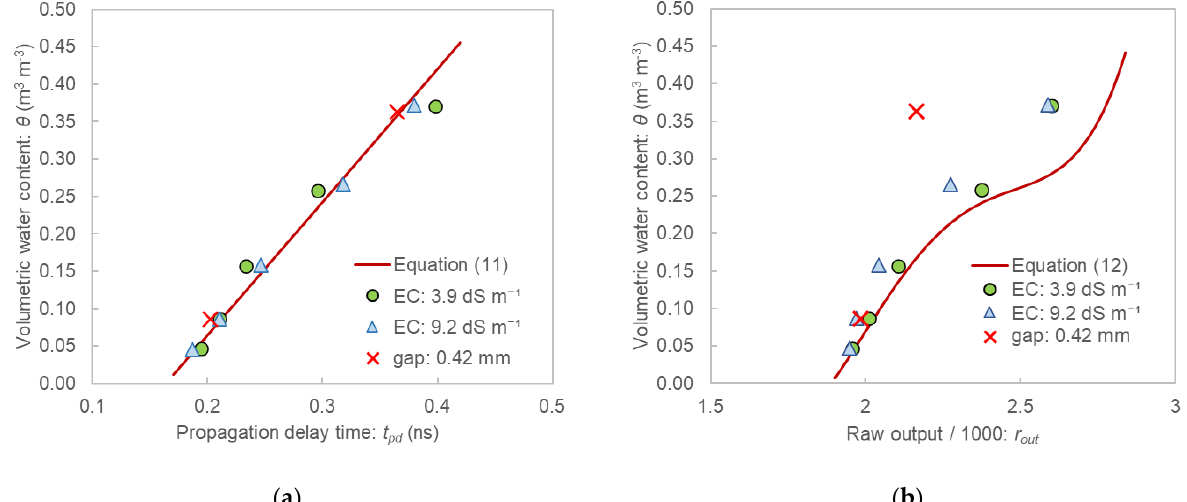
Figure 6. Relationships between the output and the volumetric water content when the saline samples were used (circle and triangle marks) and when the tape was wrapped around the sensors to simulate air gaps (cross marks): ( a ) for the SFDT sensor; ( b ) for TEROS12.